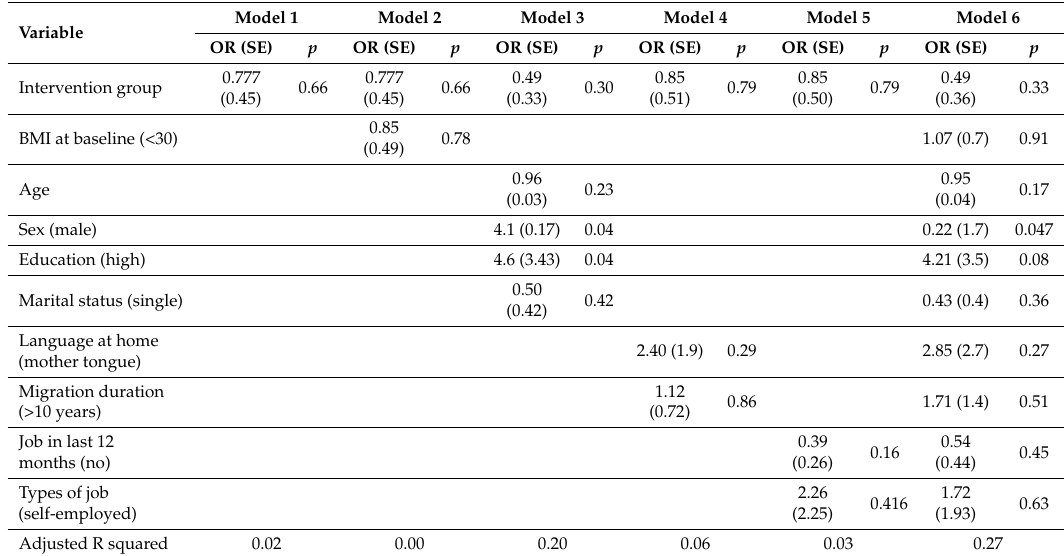
Table 2. Logistic regression predicting zero willingness to pay (zero value = 0).